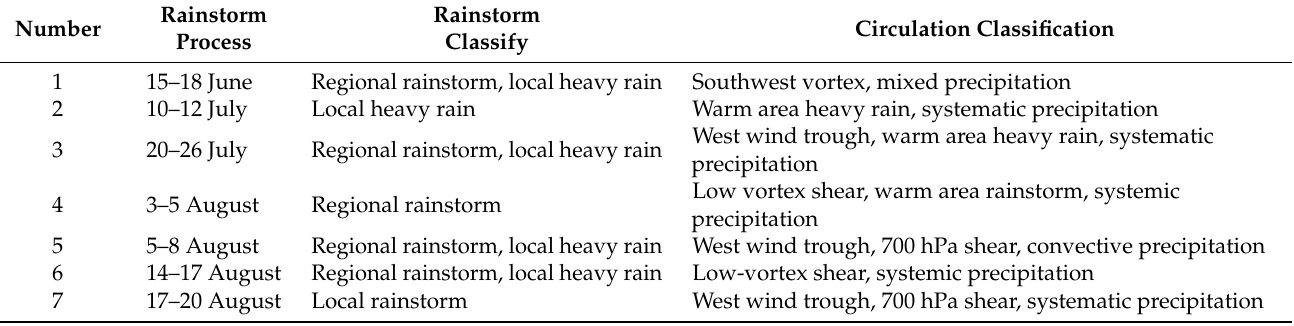
Table 1. Circulation classification of selected rainstorm cases in Qinling mountains and their sur- rounding areas.